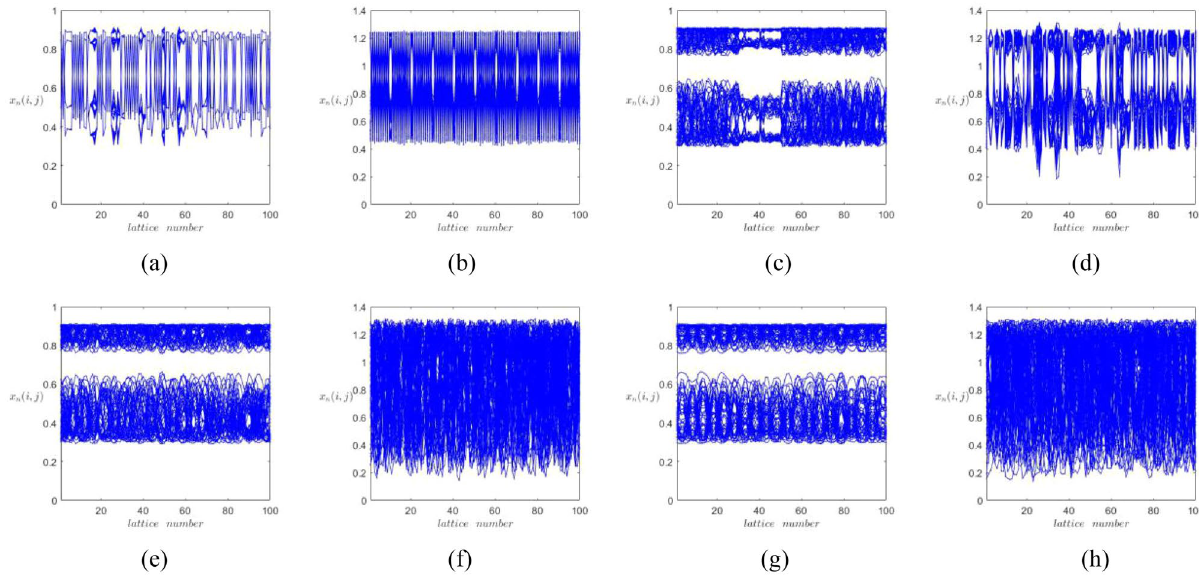
Figure 6. The space-amplitude plots when times = 1000. ( a ) the 2DCML system ( ε = 0.1), ( b ) the proposed system ( ε = 0.1), ( c ) the 2DCML system ( ε = 0.3), ( d ) the proposed system ( ε = 0.3), ( e ) the 2DCML system ( ε = 0.5), ( f ) the proposed system ( ε = 0.5), ( g ) the 2DCML system ( ε = 0.7), ( h ) the proposed system ( ε =